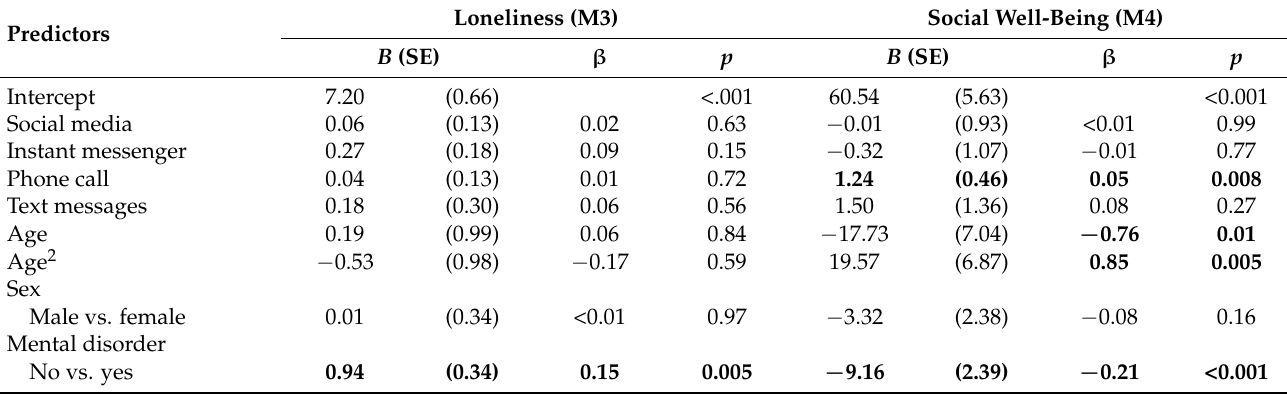
Table 4. Results from multiple regression analysis predicting self-reported loneliness and social well-being by type of smartphone communication app use time (average of past seven days) of 359 German adults.